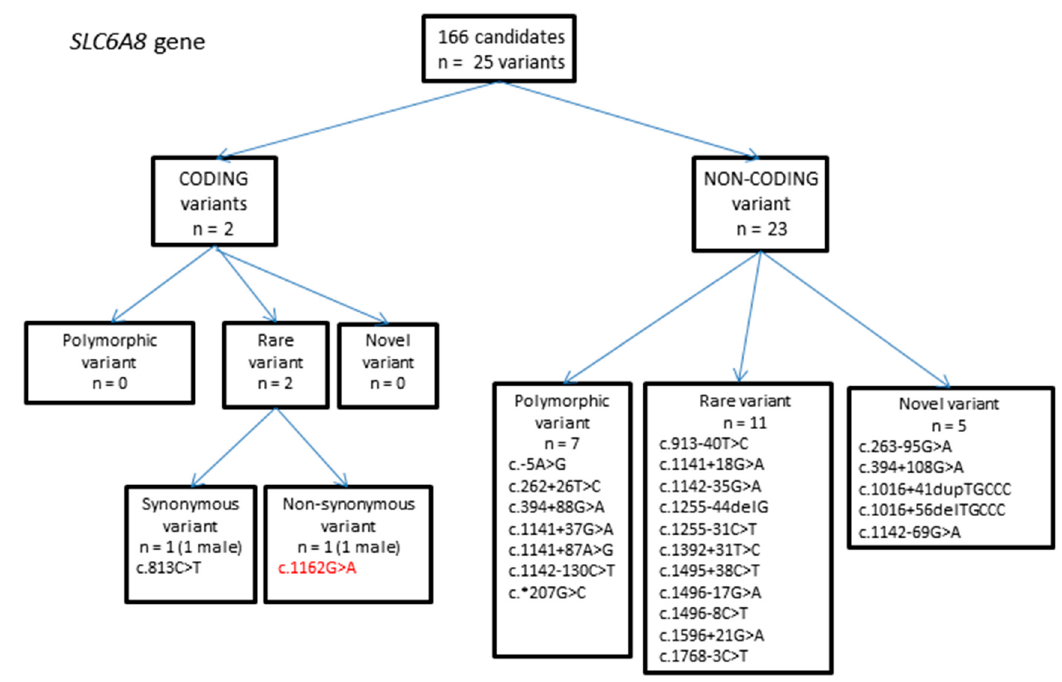
Figure 3. Flowchart summarizing variants identified in the solute carrier family 6 member 8 ( SLC6A8) gene.